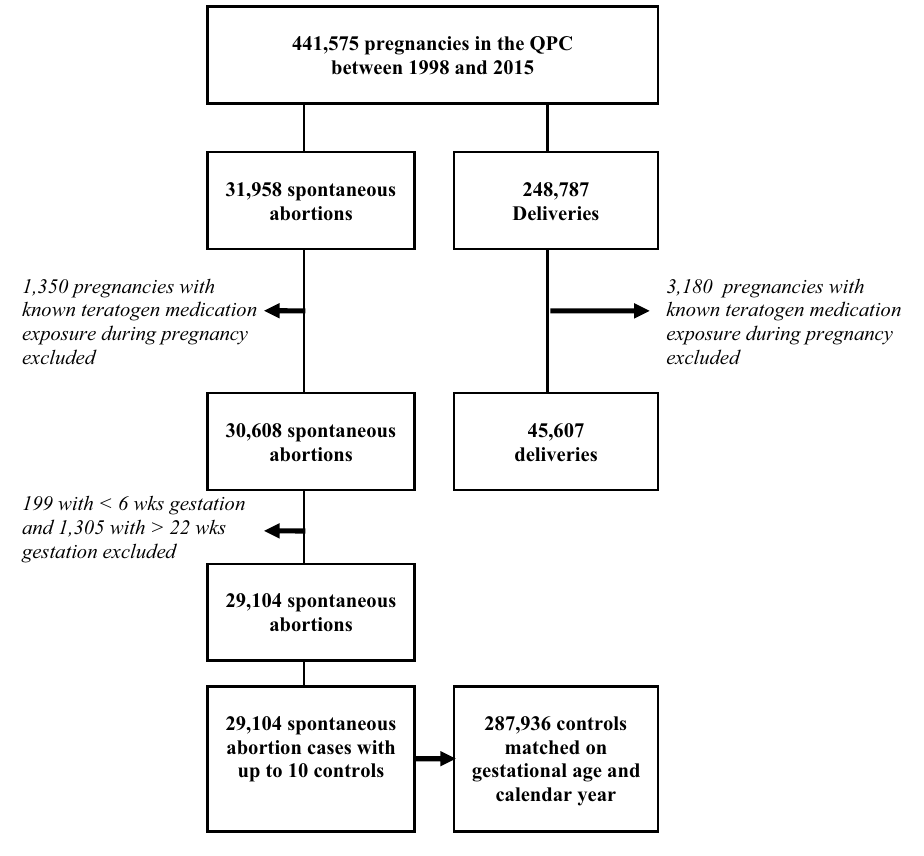
Figure 2. Selection of cases and controls for the analyses on spontaneous